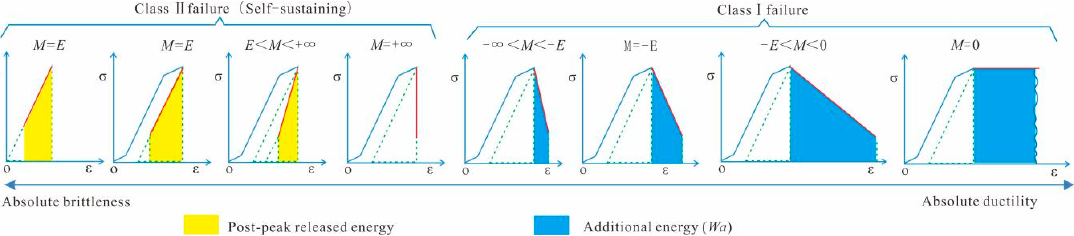
Figure 2. Post-peak energy balance for rocks of class I and class II, E : Young’s modulus; M : drop modulus (modified from [8]).